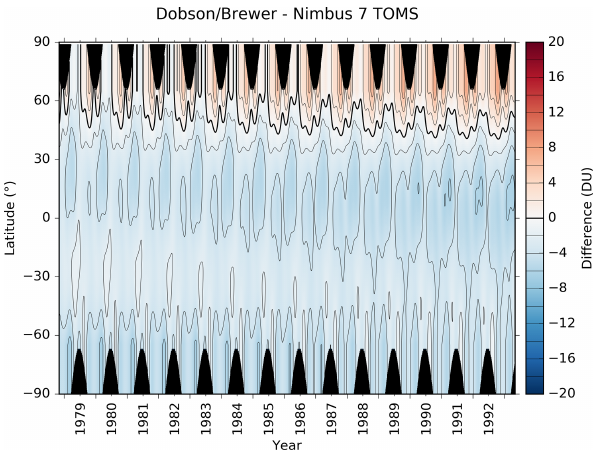
Figure 2. The results obtained by fitting Eq. (1) to the differ- ences between Dobson/Brewer ground-based TCO measurements and Nimbus 7 TOMS overpass TCO measurements (ground-based minus satellite). Regions shaded in black denote the polar night where neither ground-based nor space-based measurements are pos- sible. The thick black line denotes the zero contour. Differences are shown in Dobson units (DU; 1DU = 2 . 69 × 10 16 moleculescm − 2